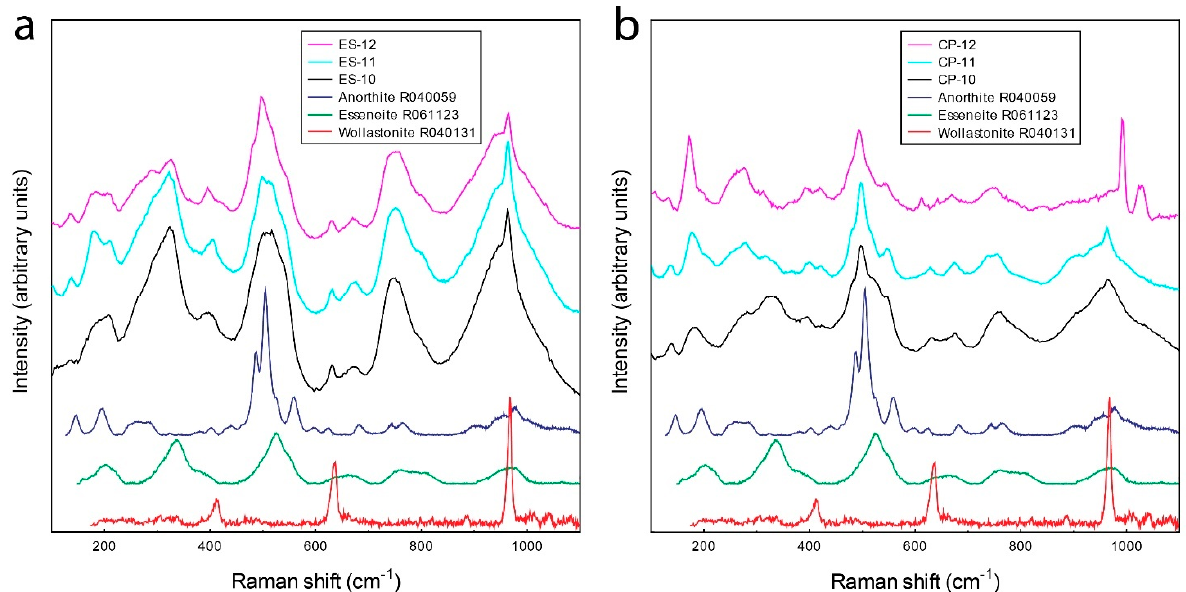
Figure 7. The Raman spectra of epidote ( a ) and clinozoisite ( b ) samples, heat-treated at temperatures higher than 1000 °C,